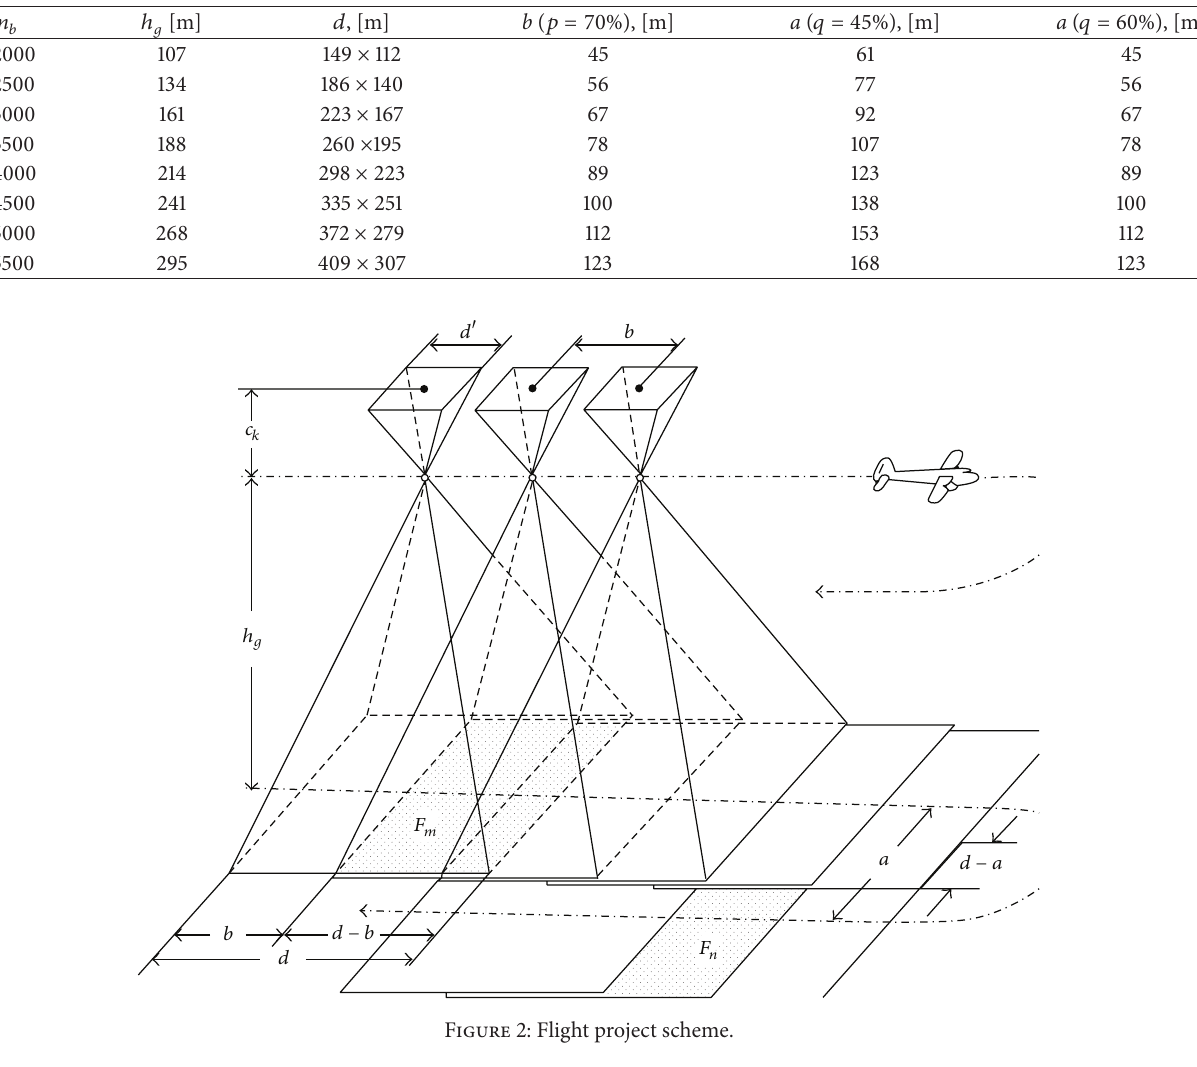
Table 2: Flight project values, with camera Canon S100.